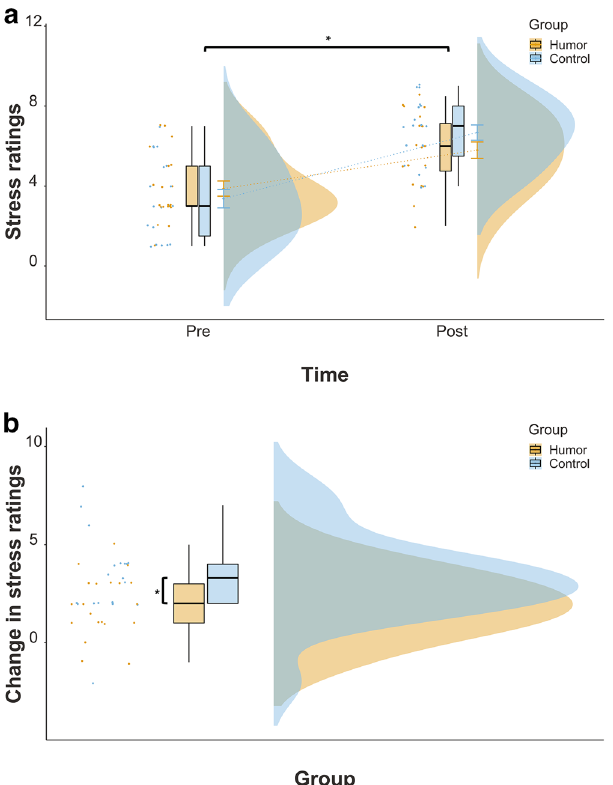
Figure 1. (a) Psychological stress levels before and after the stress test as a function of group. Asterisks (*) indicate statistically significant differences: * p < .05. Error bars denote the standard error of the (group) mean. (b) Change of psychological stress levels as a function of group. To measure the change in psychological stress levels, the difference between stress ratings pre- and succeeding the stress test was calculated. Asterisks (*) indicate statistically significant differences: * p <